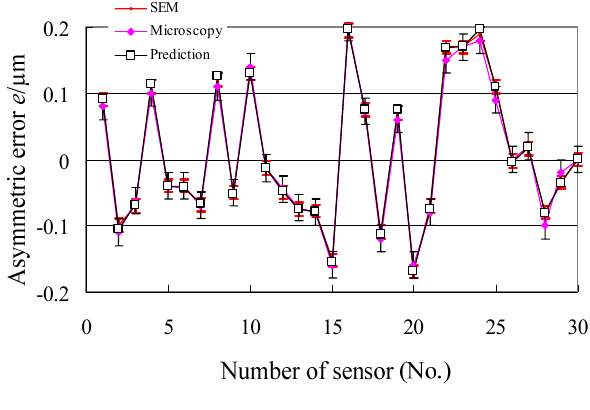
Figure 11. The measurement results of thirty